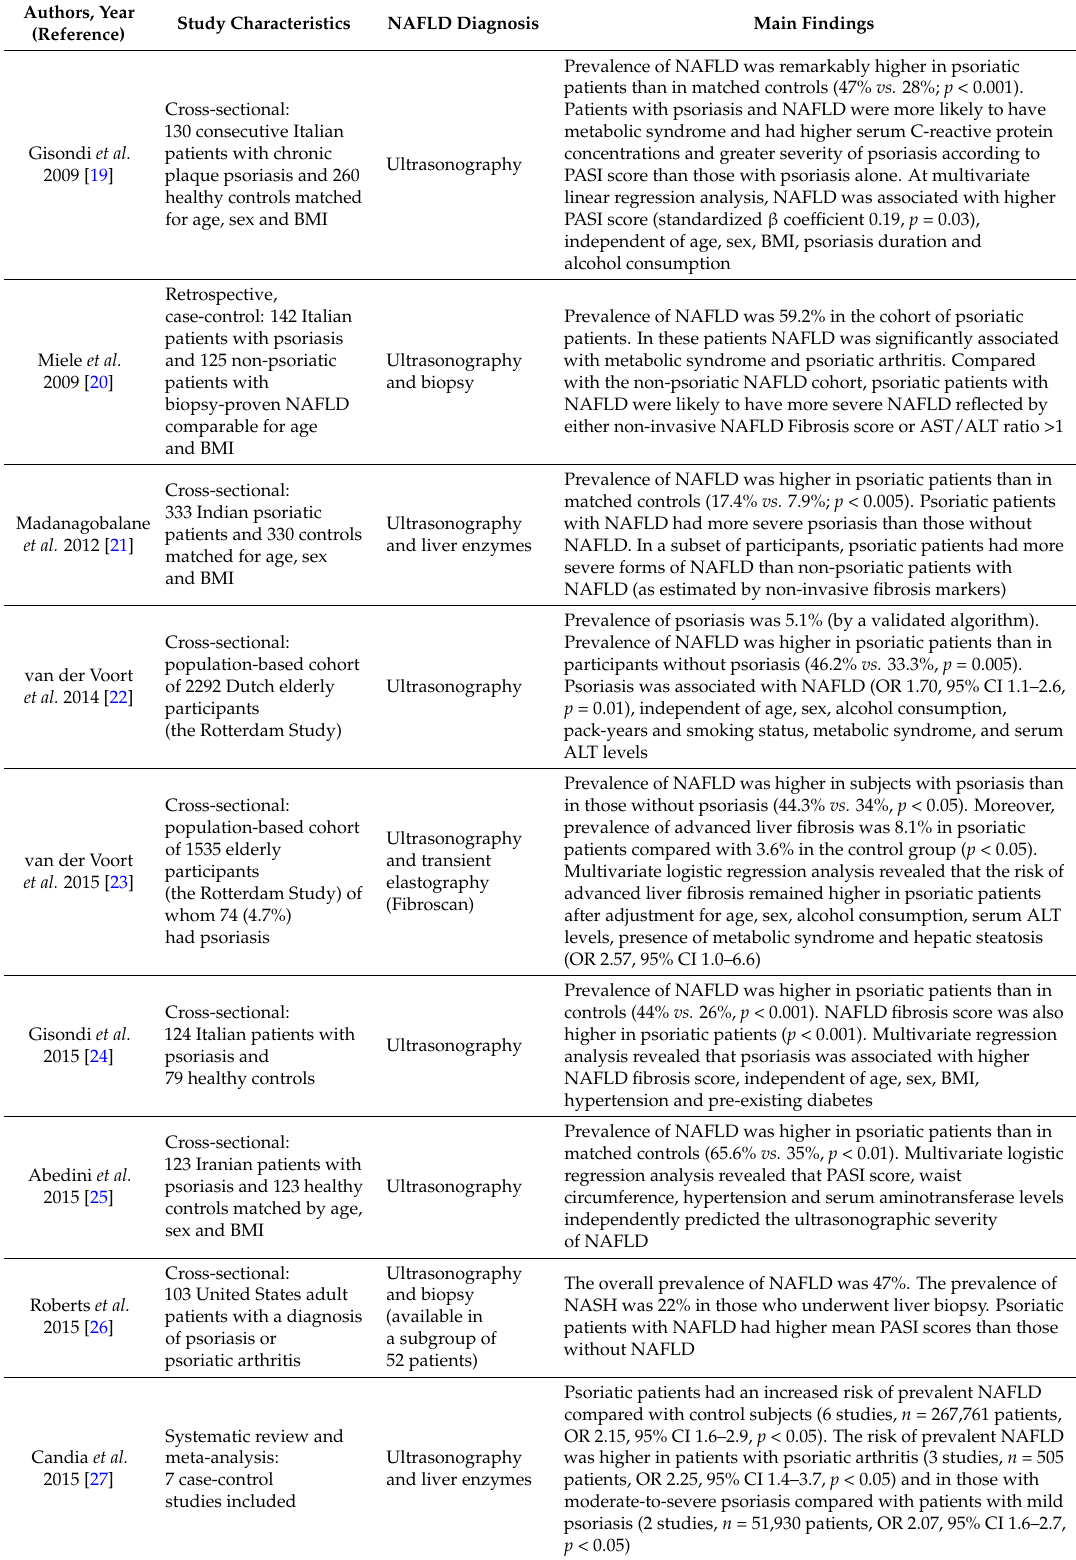
Table 1. Principal studies examining the relationship between NAFLD and psoriasis (ordered by publication